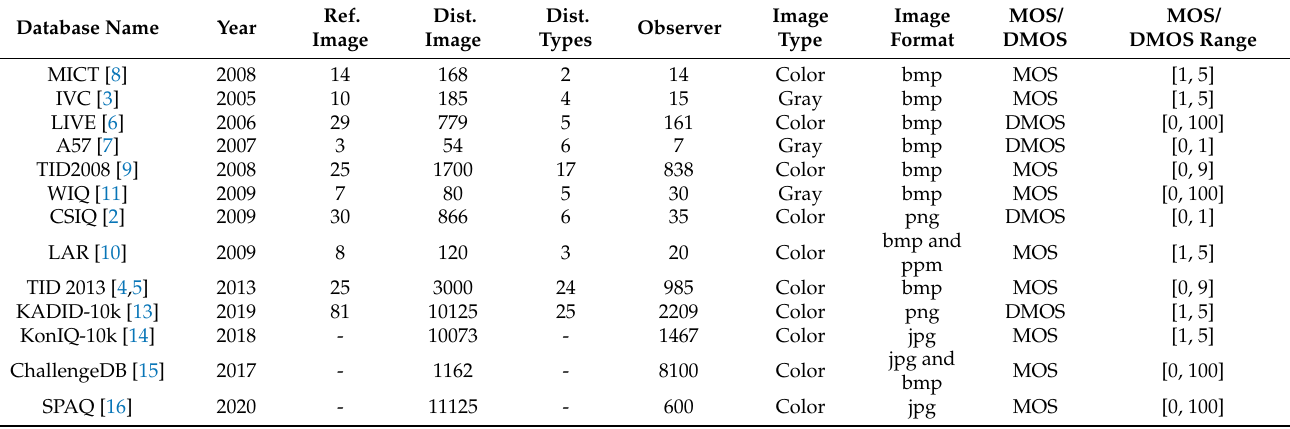
Table 1. Details of popular image quality